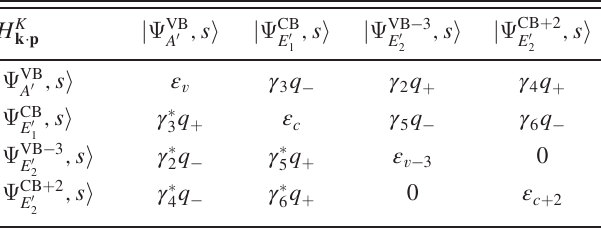
TABLE V. The k · p matrix elements between symmetric states at the K